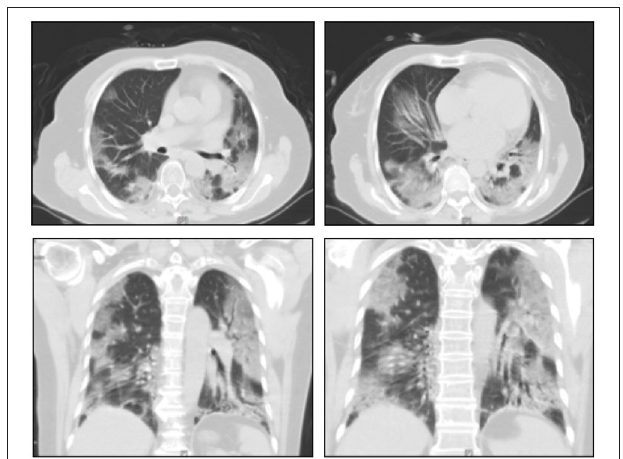
FIGURE 1 | Representative images of the thoracic CT scans. Chest computed tomograms showing multifocal bilateral ground glass opacities with patchy consolidations, prominent in the peripheral distribution on day 4 after symptom